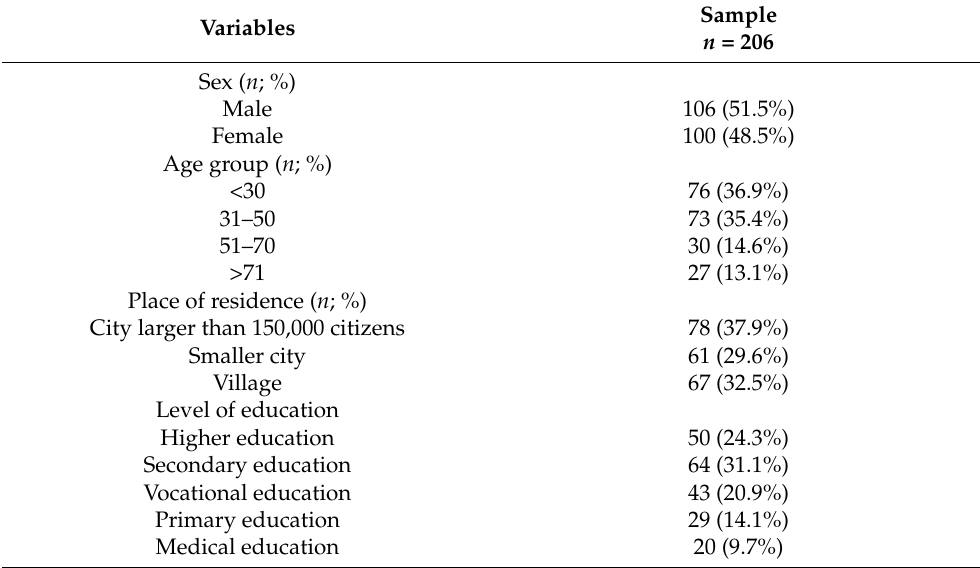
Table 1. Characteristics of the study